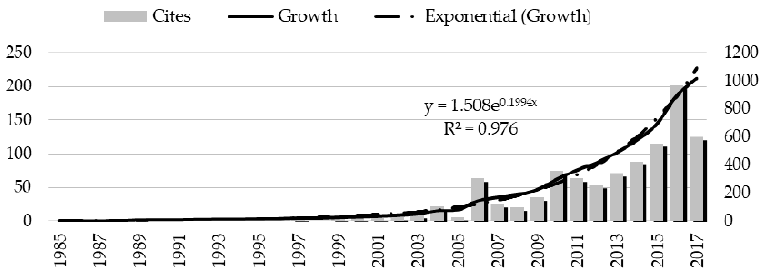
Figure 3. Annual number and growth of citations received by articles on Religious Tourism. ( Source: Own elaboration).